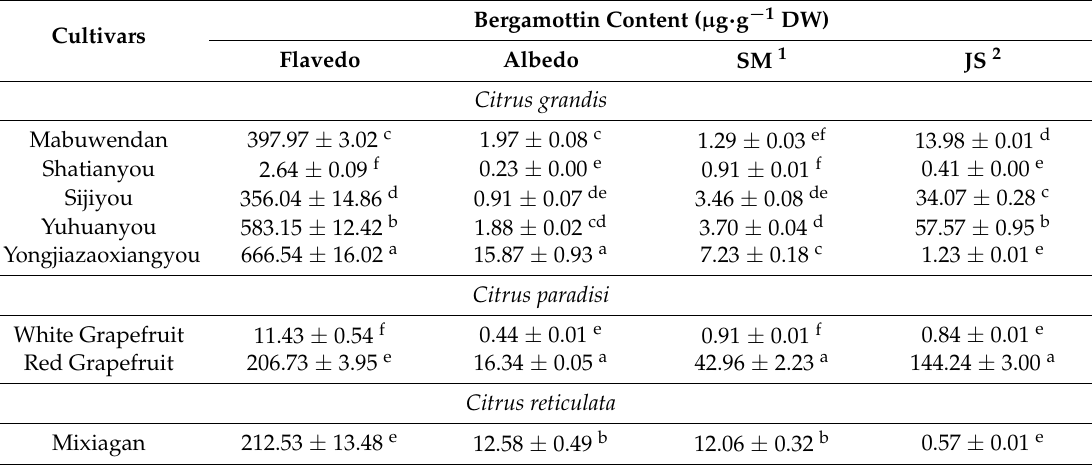
Table 1. Bergamottin content in different tissues of eight citrus